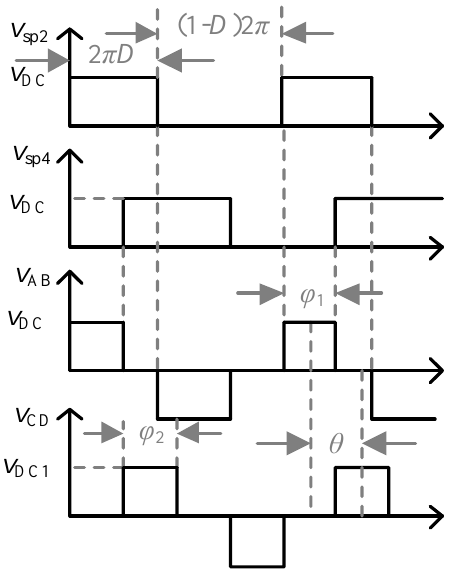
Figure 2. TPS plus duty cycle modulation scheme.